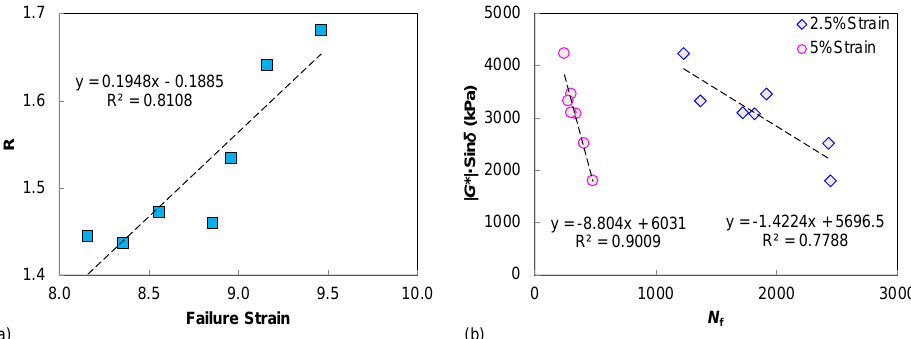
Figure 7. The relationships between LAS results and LVE parameters: ( a ) failure strain vs. R ; ( b ) N f vs. | G* |·sin δ .